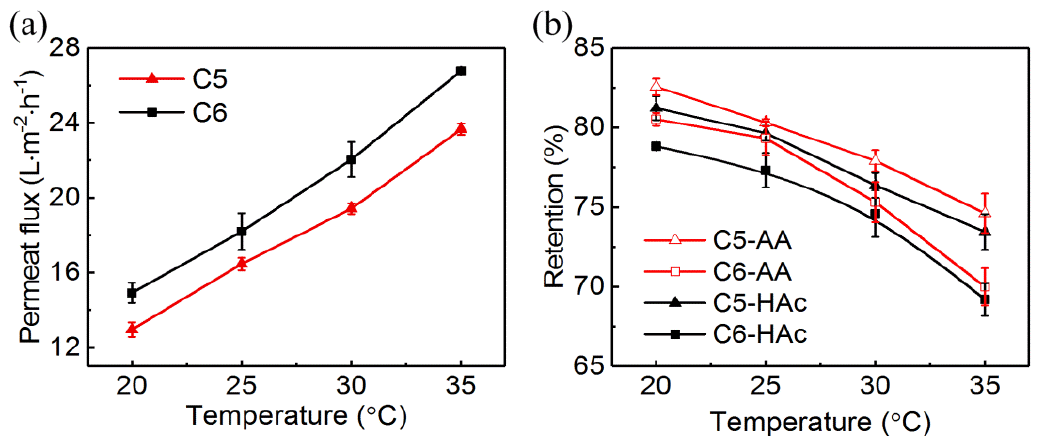
Figure 3. E ff ect of temperature on ( a ) permeate flux and ( b ) acrylic acid and acetic acid retentions. The concentrations of acrylic acid and acetic acid were 2.5%, 1.5%, respectively; pressure: 3.5 MPa.